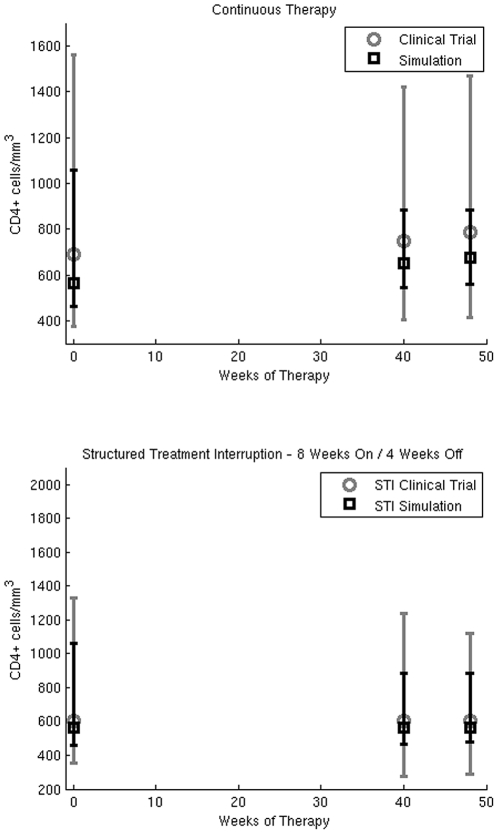
Model validation: CD4+ cell counts/mm3 at three different time points (Baseline, Week 40 and Week 48).In the upper panel we compare the median CD4+ cell counts of 250 virtual patients with the data of real patients from the continuous treatment arm of Dybul's clinical trial. In the lower panel we compare the median CD4+ cell counts of 250 virtual patients with the data of real patients from the STI arm of Dybul's clinical trial.